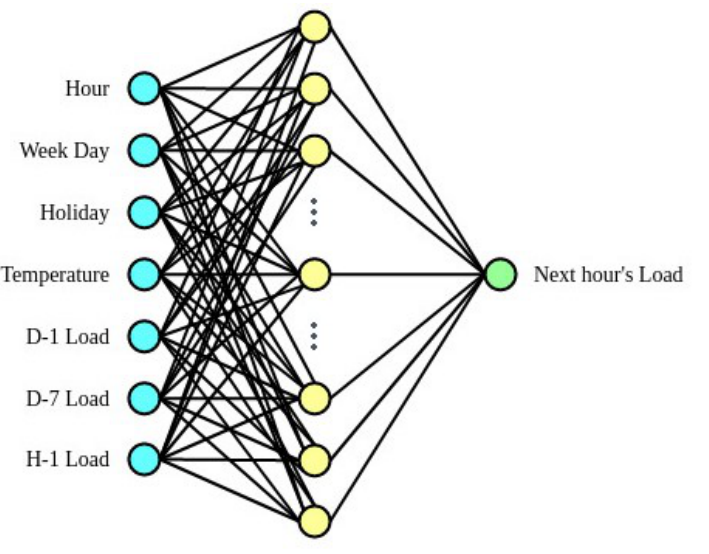
Figure 1. The structure of the proposed MLP neural network.